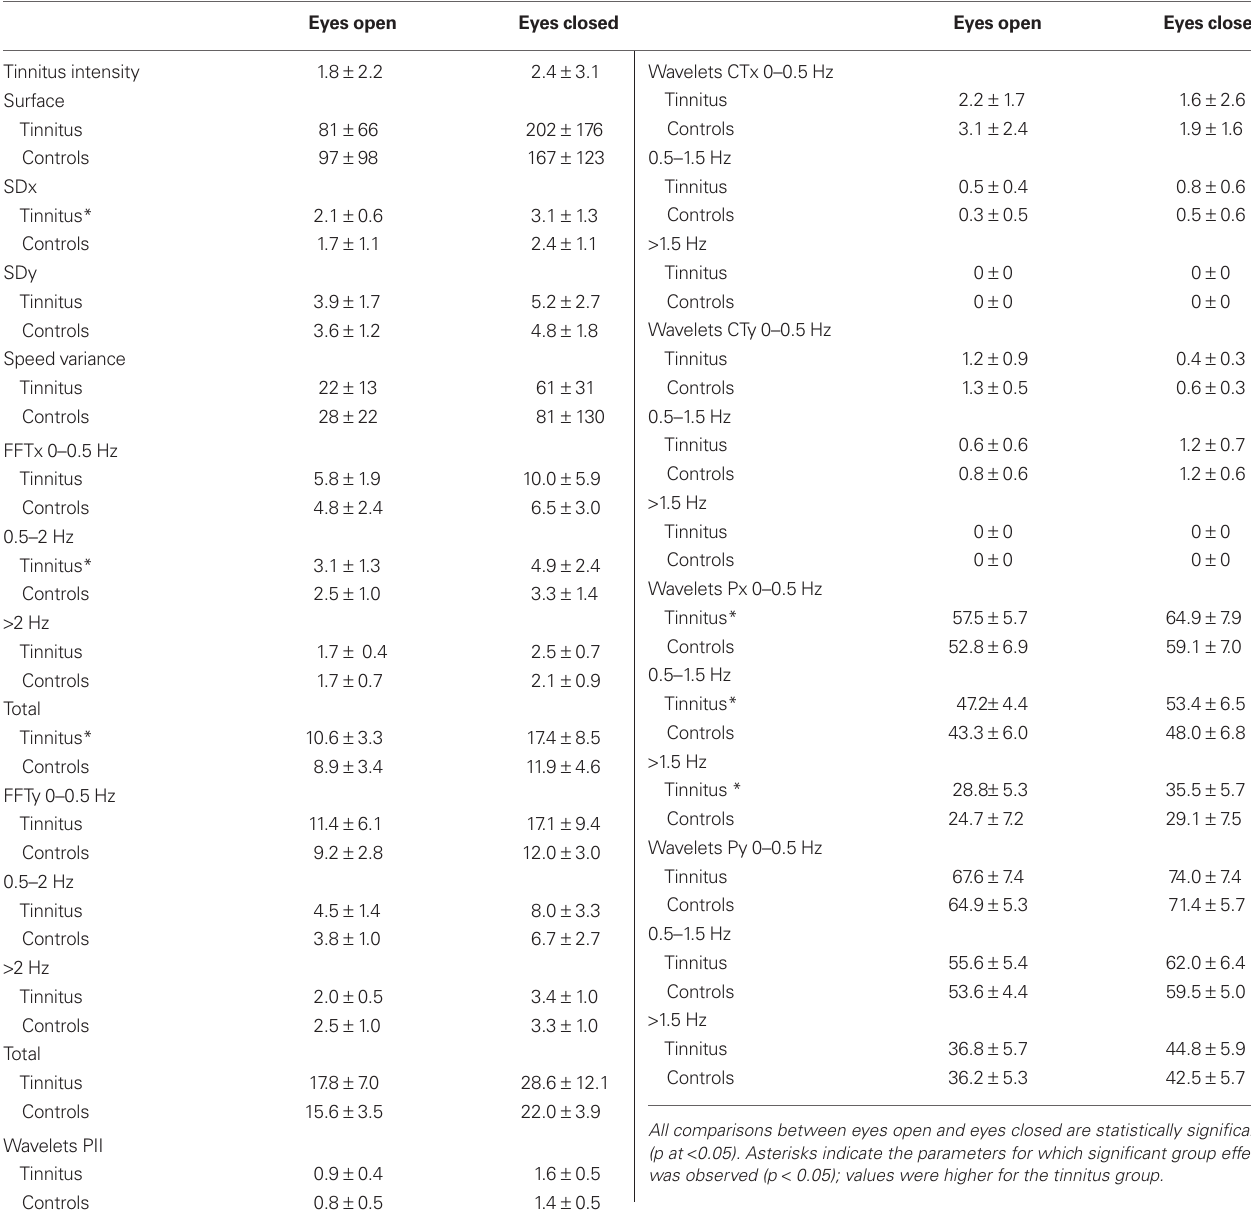
Table 2 | Group mean values for each parameter of posturography for the control and tinnitus groups (16) matched for sex and age.